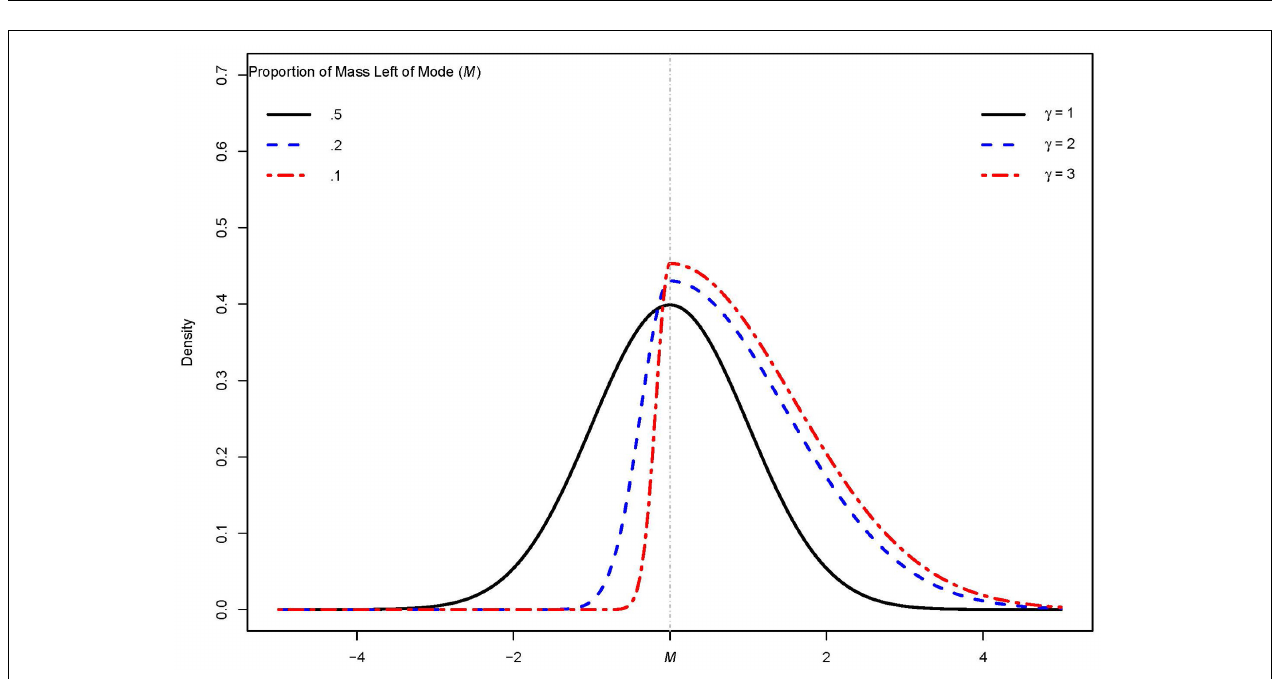
FIGURE 2 | Example of the influence of shape parameter γ on the allocation of mass for a normal distribution with a variance of 1.